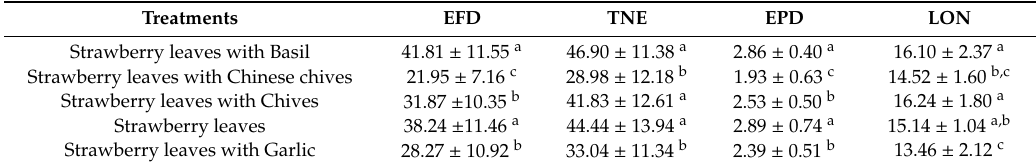
Table 2. Number of eggs laid by Tetranychus urticae females on first five days (EFD), total number of eggs (TNE), eggs per day (EPF), and female longevity (LON) (days) means ( ± Standard deviation) in control, solely containing strawberry leaves or those where strawberry leaves were placed with aromatic plants in boxes.